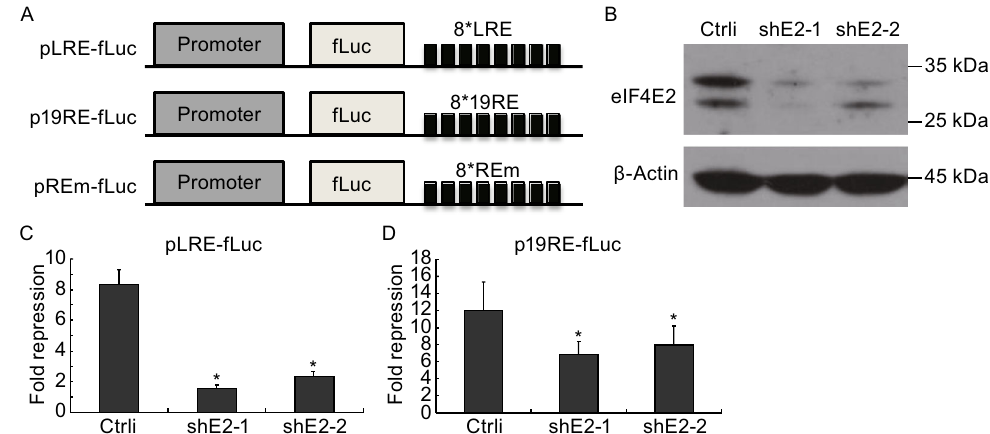
Figure 3. Downregulation of eIF4E2 impairs miRNA repression of reporter expression. (A) Schematic representation of reporter plasmids expressing fi re fl y luciferase (fLuc). Eight tandem Let-7a response elements (LRE), miR-19 response